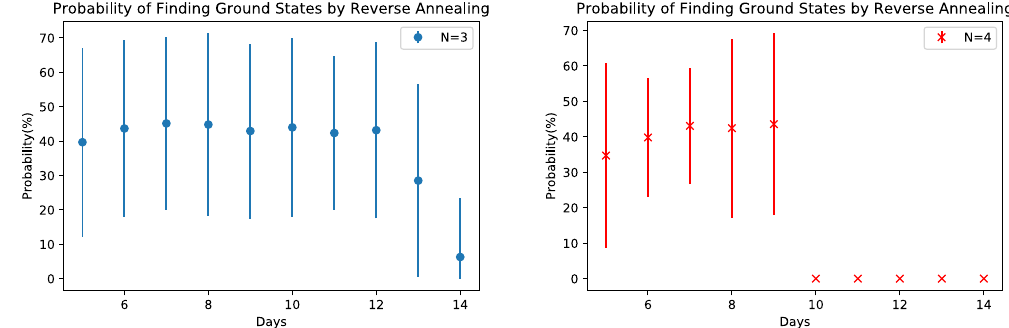
Figure 7. Probability of finding the ground states of the NSP Hamiltonian by reverse annealing. Error bars are based on the standard deviation (1000 samples times 10 shots for each problem).